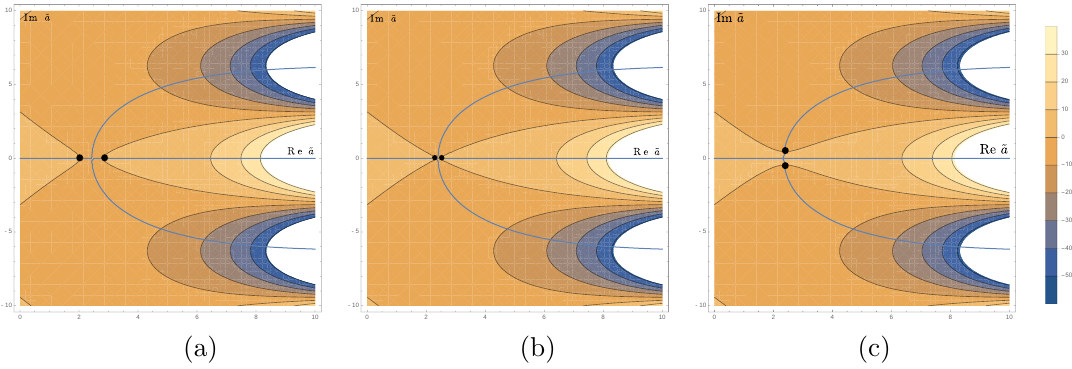
Figure 2 . Transition from real to complex leading solutions at T cr . Shown are the contour plots of the real part of the constraint (3.14) together with the contour line given by Im(constraint) = 0 , shown by the blue curves. (a) J T = 1 . 3 ; (b) J T = 1 . 325 ; (c) J T = 1 . 360